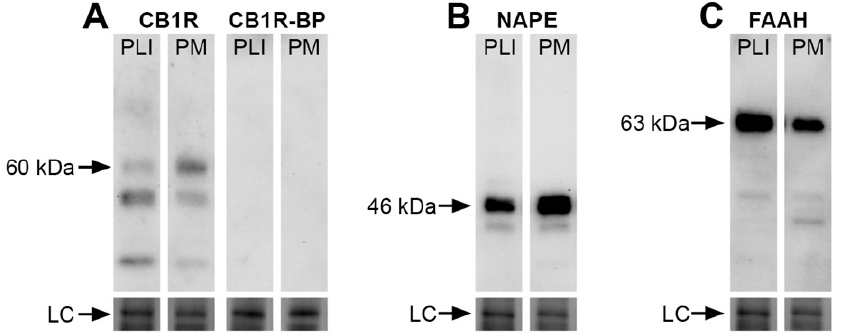
Figure 1. Presence of CB1R, NAPE-PLD or FAAH in the pulvinar of the vervet monkey. A Western blot analysis of the total protein samples of the inferior + lateral (PI + PL) and medial (PM) pulvinar subdivisions for the CB1R antibody ( A ) show the detection of the expected major protein band at 60 kDa. The band was not detected when the antibody was pre-incubated with its corresponding CB1R blocking peptide (BP) at the ratio of 1:10. For the NAPE-PLD antibody, the expected band is seen at 46 kDa ( B ). For the FAAH antibody, the expected band is seen at 63 kDa ( C ). All lanes contained 10 µg of total protein. The loading controls (LC) showing total protein content are displayed at the bottom of the lanes. CB1R: cannabinoid receptor type 1; FAAH: fatty acid amide hydrolase; NAPE-PLD: N -acyl phosphatidylethanolamine phospholipase D; PLI: lateral and inferior pulvinar; PM: medial pulvinar.